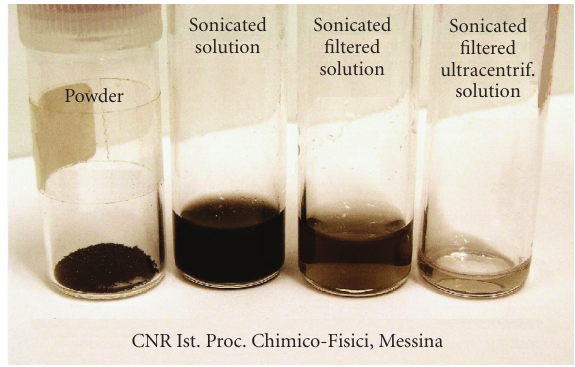
Figure 8: Pictures of the result of the debundling and dispersion process: from powders (left) to solutions of individual SWNT after ultracentrifugation